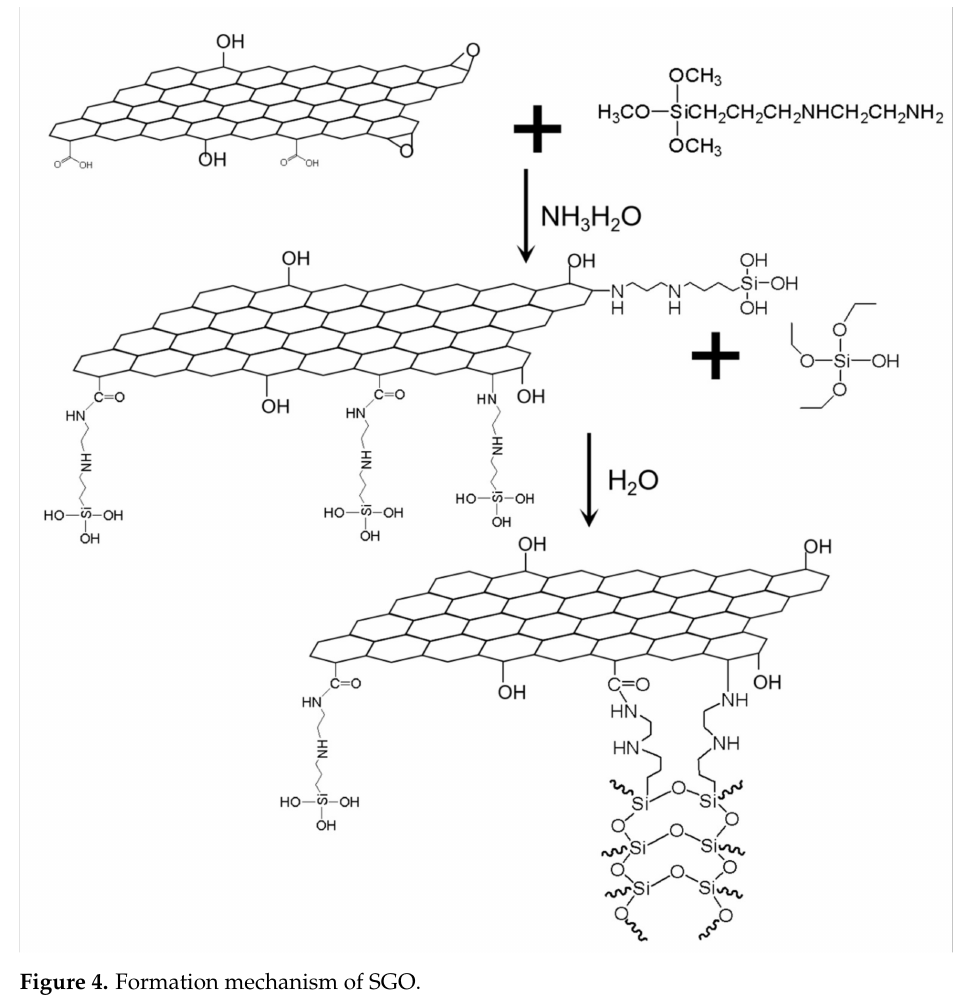
Figure 4. Formation mechanism of SGO.